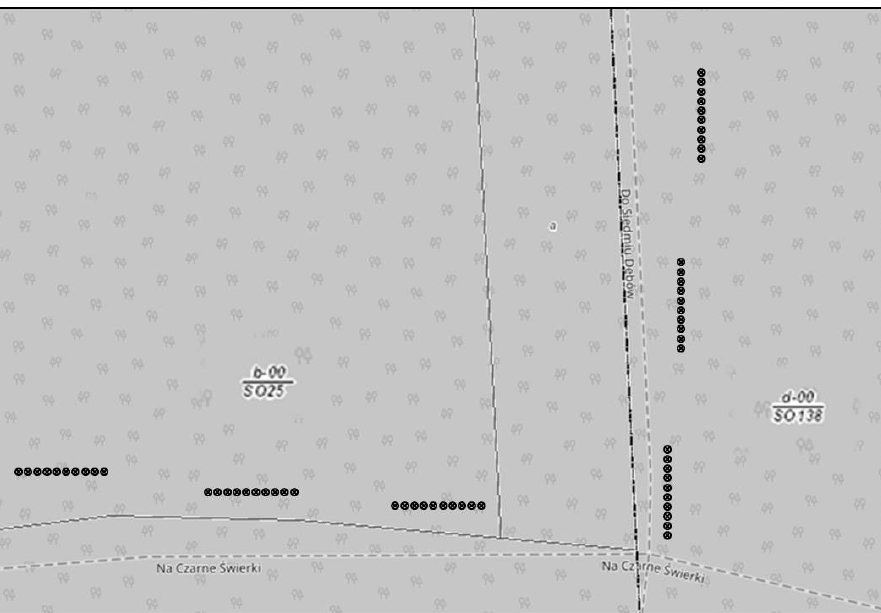
Figure 2. The simplified scheme of measure points layout within the post-fire site 3F (b-00 / pine 25 years old) and control compartment 3C not a ff ected by fire (d-00 / pine 138